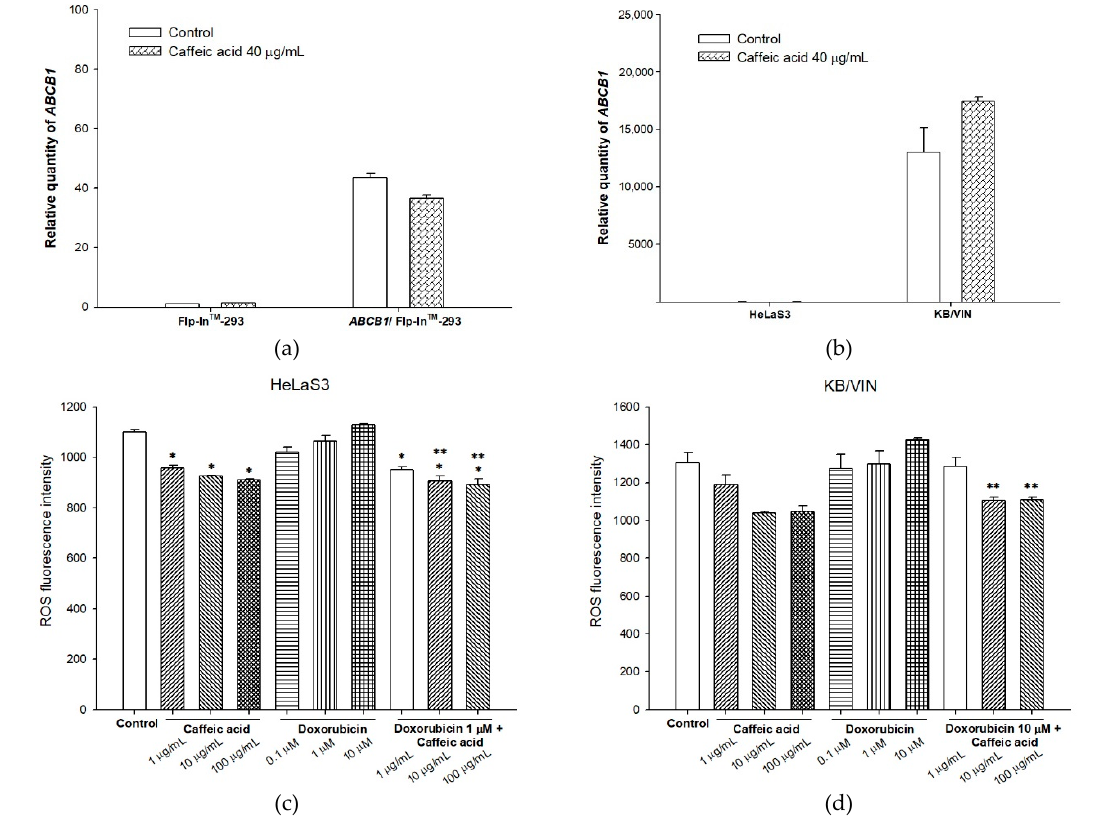
Figure 5. The modulating e ff ects of ca ff eic acid on human P-gp expression. ( a ) The ABCB1 expression in ABCB1 / Flp-In TM -293 was slightly down-regulated after treating the cells with 40 µ g / mL ca ff eic acid for 72 h. ( b ) The ABCB1 expression in KB / VIN was slightly up-regulated after treating the cells with 40 µ g / mL ca ff eic acid for 72 h. ( c ) The intracellular ROS production under the treatment of ca ff eic acid with or without doxorubicin in HeLaS3. ( d ) The intracellular ROS production under the treatment of ca ff eic acid with or without doxorubicin in KB / VIN. Data were presented as mean ± SE of at least three experiments, each in triplicate. * denotes p < 0.05 compared with the control group. ** denotes p < 0.05 compared with the doxorubicin 1 µ M group in Figure 5c and doxorubicin 10 µ M group in Figure